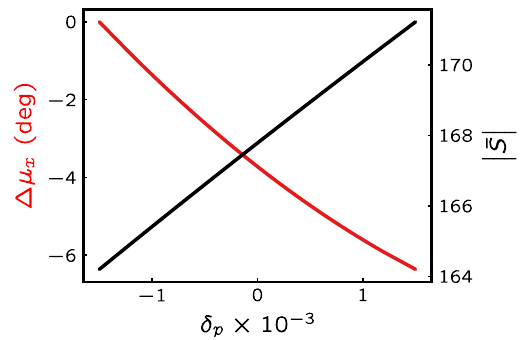
FIG. 2. Variation of the amplitude and phase of the virtual sextupole (driving term) during the spill with the SPS tune sweep slow extraction.